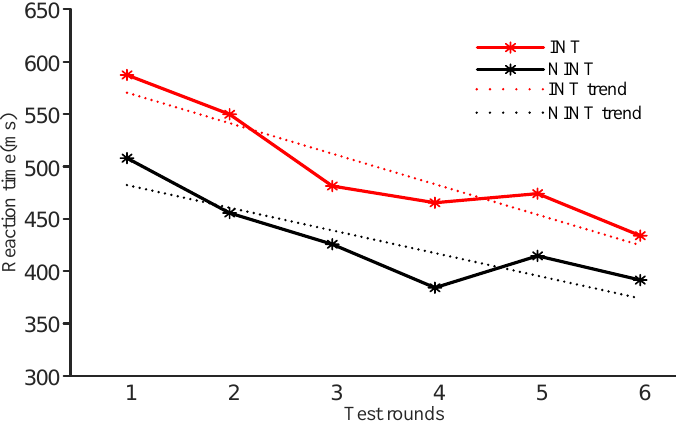
Figure 7. Changes in AX-CPT reaction times for the two groups.